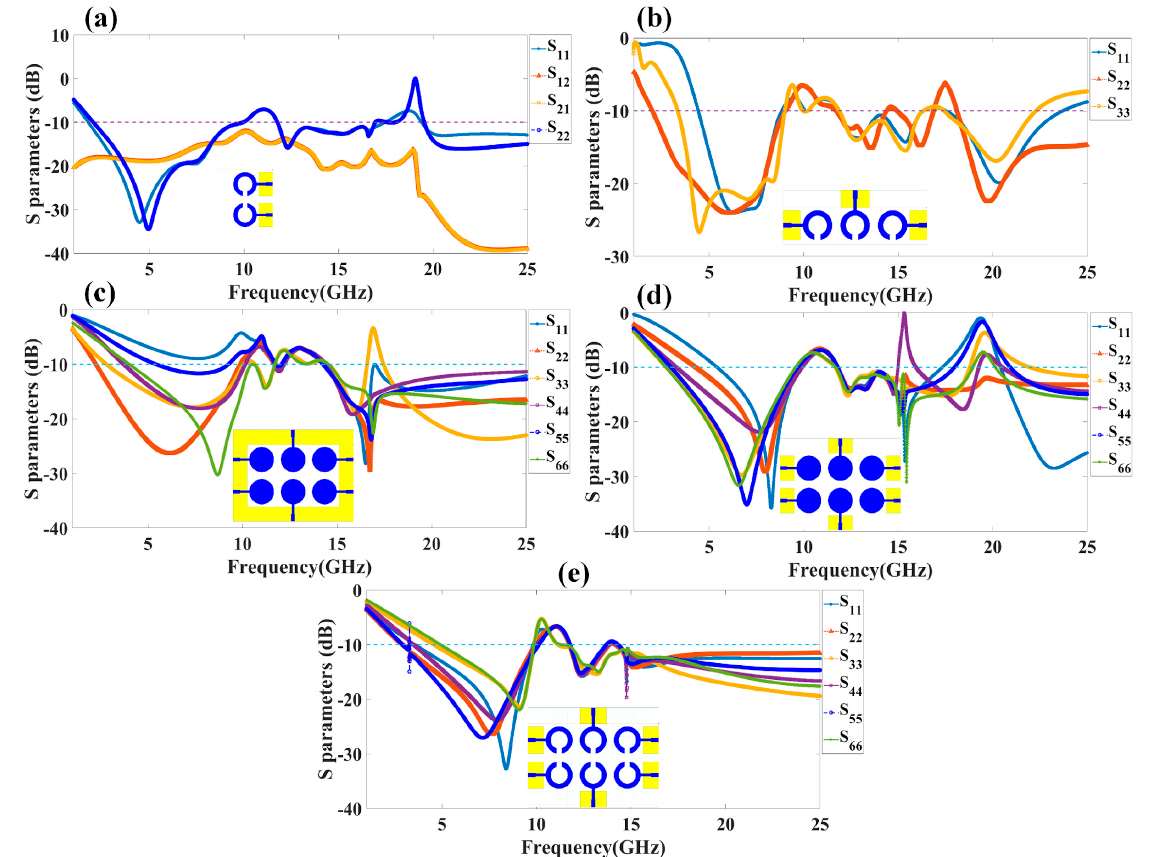
Figure 2. Numerically calculated reflectance coefficients for the different proposed MIMO antenna designs: ( a ) Design 1, ( b ) Design 2, ( c ) Design 3, ( d ) Design 4, and ( e ) Design 5. The results are pre-